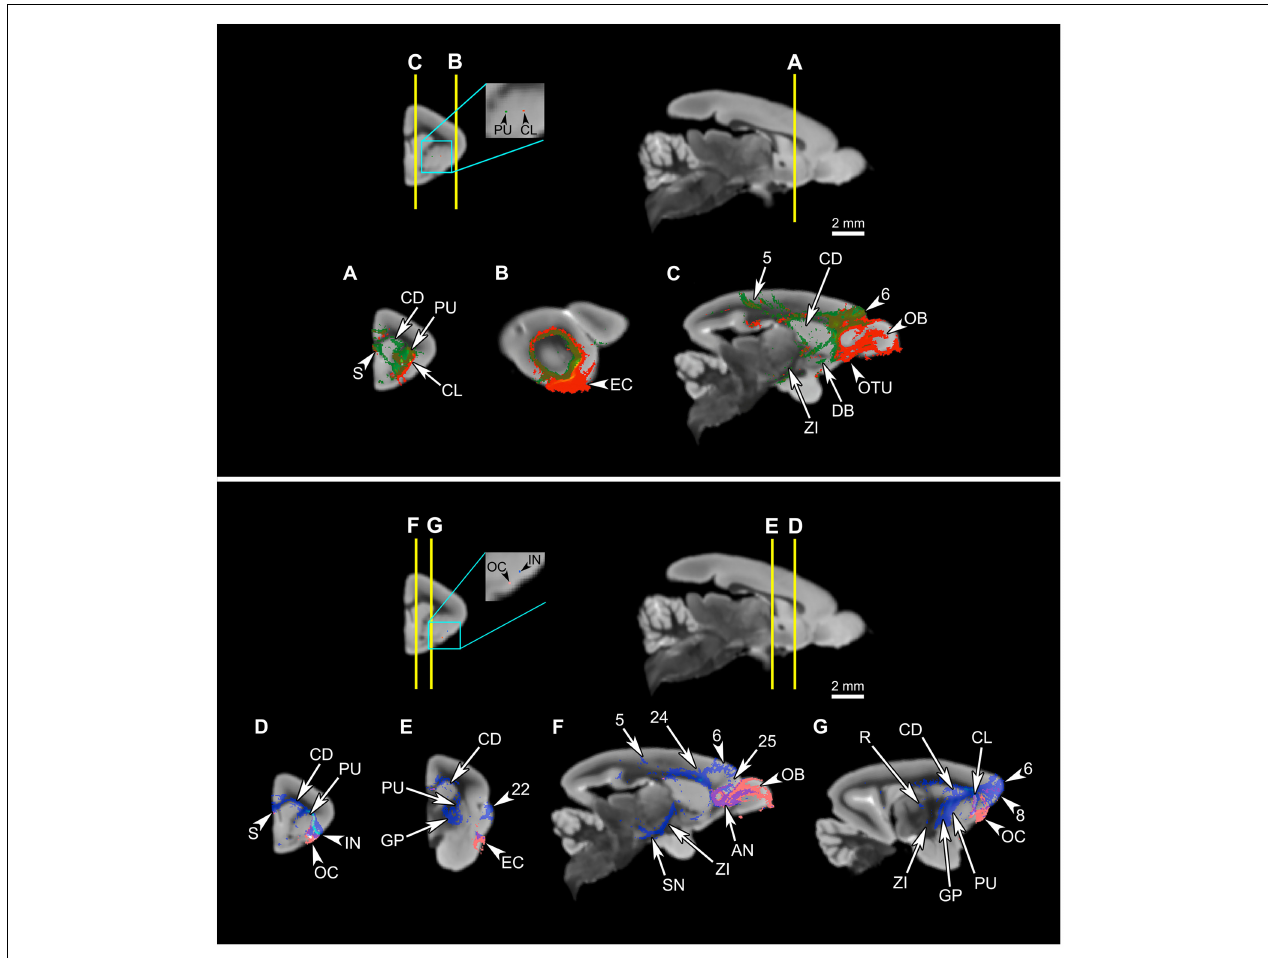
The first row shows the levels of cross-section for (D–G) , and the locations of the seeds in the olfactory cortex and the insula. (D–G) Despite the proximity of the two seeds, the tract originating from the olfactory cortex is significantly different from the insular tract, connecting to the olfactory bulb (F) , anterior olfactory nucleus (F) , and the entorhinal cortex (E) , while avoiding most of the regions connected to the insula. Abbreviations: AN, anterior olfactory nucleus; CD, caudate; CL, claustrum; DB, diagonal band; EC, entorhinal cortex; GP, globus pallidus; IN, insula; OB, olfactory bulb; OC, olfactory cortex; OTU, olfactory tubercle; PU, putamen; R, reticular thalamic nucleus; S, septum; SN, substantia nigra; ZI, zona incerta.The cortical area numbers are based on Le Gros Clark’s (1931) map of Microcebus